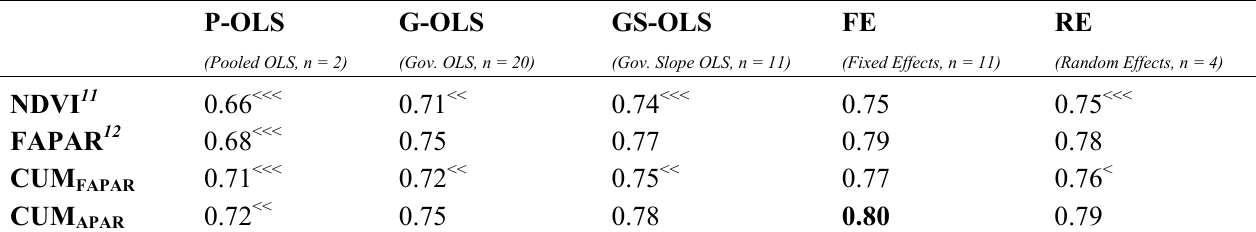
Table 1. Jackknifed (cid:1844) (cid:3042)(cid:3049)(cid:3032)(cid:3045)(cid:3028)(cid:3039)(cid:3039)(cid:2870) with BP in rows and models in columns. R 2 that are